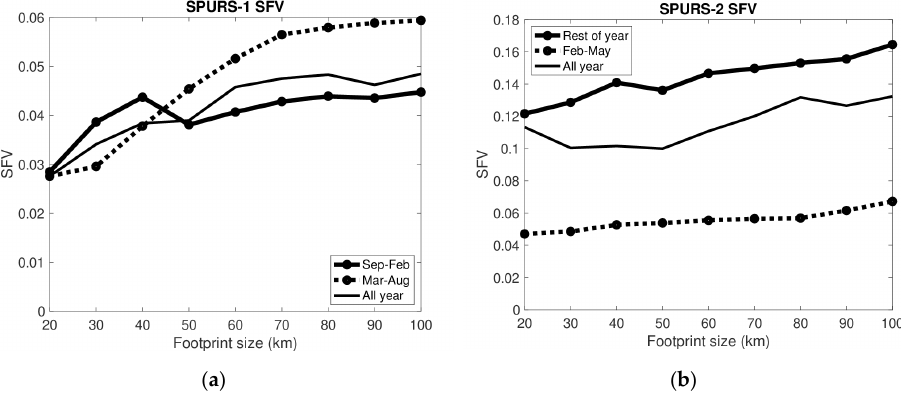
Figure 3. Median SFV ( σ 50 ) vs. footprint size in the SPURS regions. Solid lines with markers: wet season. Thinner solid lines with no markers: all year, same as curves shown in Figure 2. Dashed lines with markers: dry season. ( a ) SPURS-1. Dry season is March–August. ( b ) SPURS-2. Dry season is February–May. Note vertical axes are not consistent between the panels.